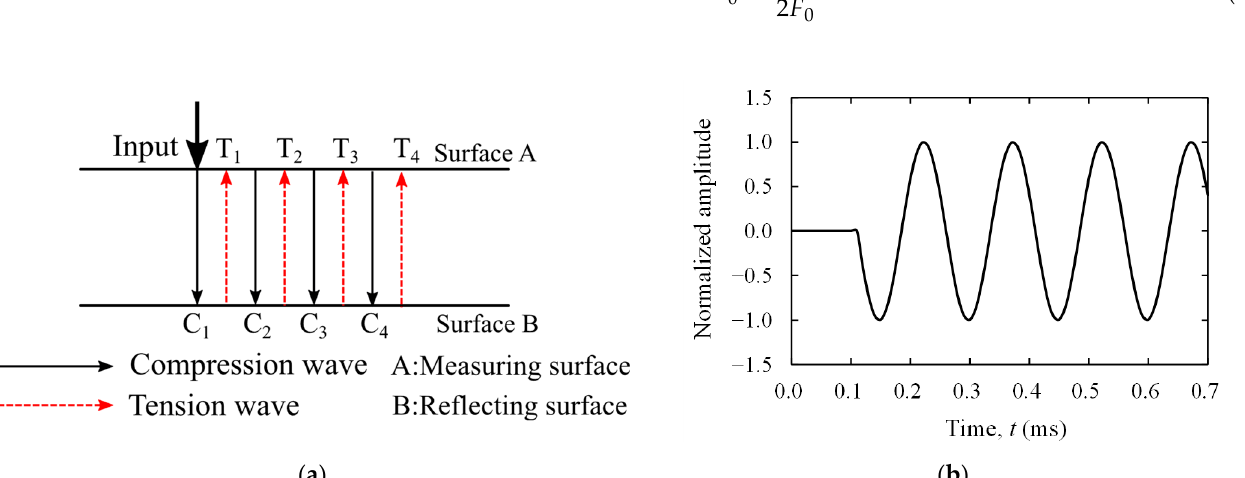
Figure 3. Schematic illustration of the IEW method: ( a ) Schematic wave path; ( b ) Example of waveform.